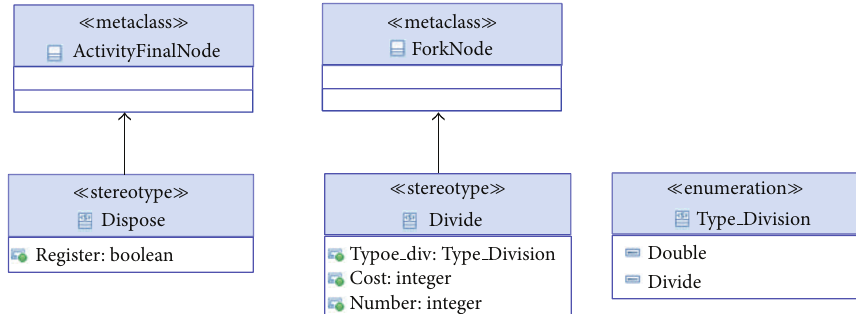
Figure 9: Metaclass ActivityFinalNode and ForkNode with its extended stereotypes.